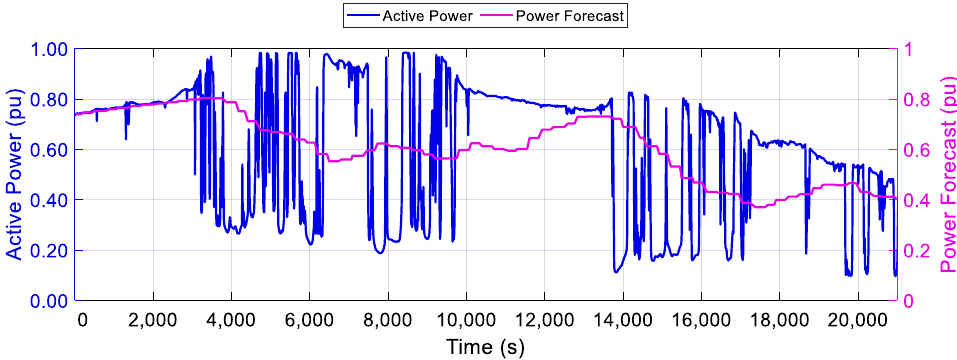
Figure 12. Forecasted PV Production and Active Power Profile for the Field Demonstration.